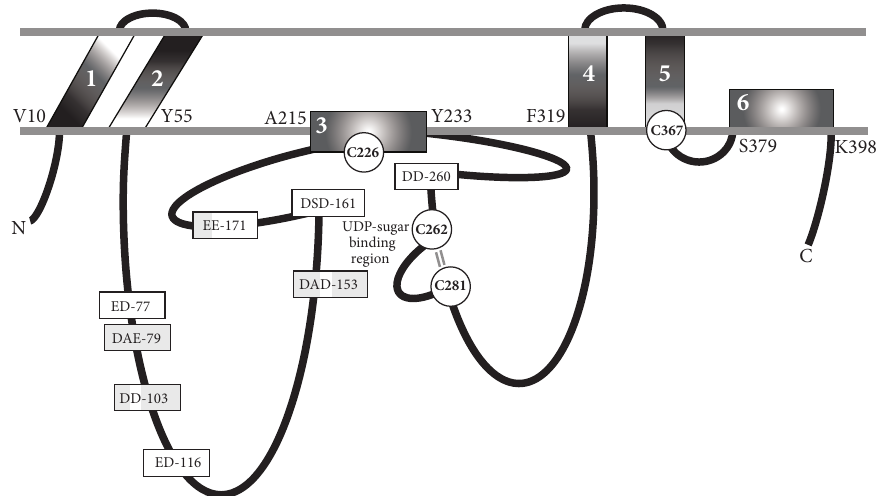
Figure 2: Membrane organization of HAS domains and conserved potential glycosyl-UDP binding regions. The experimentally determined topology of SpHAS [28] is modified to incorporate the discovery [46] that all four Cys residues of SeHAS (white circles) are at the membrane- protein interface and are located in or very near to thesugar-UDP binding sites. These four Cys residues are positionally conserved in the Class I HAS family. The SeHAS numbering shows the amino acids at the cytoplasmic junctions of the six MDs (white numbers 1–6). The parallel lines (gray) between C262 and C281 indicate the close proximity ( ∼ 5 A) of these residues; they are not disulfide bonded. Eight “DXD”- or “XDD”-equivalentmotifsinSeHAS,potentialglycosyl-UDPbindingsites(rectangleboxes),areeitherconservedjustamongthestreptococcal enzymes (light gray) or also among the eukaryotic HASs (white); a few exceptions are discussed in the text. In some motifs, a streptococcal acidic residue is shaded white to indicate its conservation in the HAS